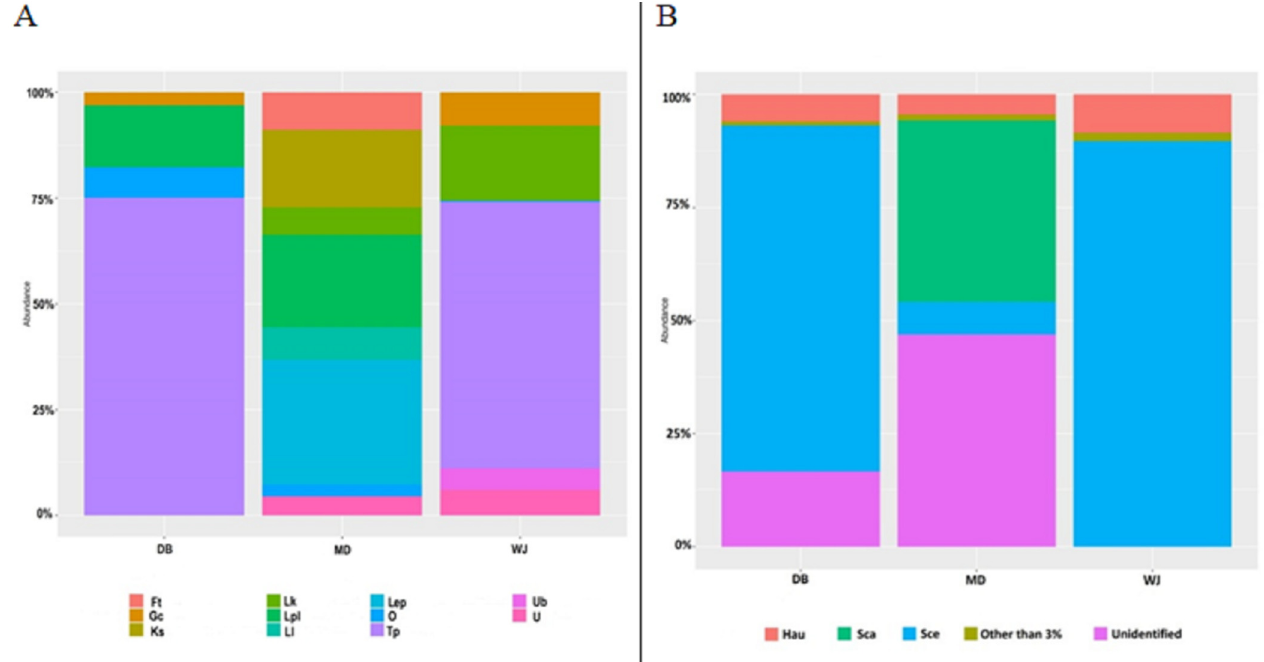
Figure 1. Bar plots showing relative abundance of bacterial ( A ) and yeast ( B ) species in wine samples. Abbreviations ( A ): Ft— Fructobacillus tropaeoli , Gc— Gluconobacter cerinus , Ks— Komagataeibacter